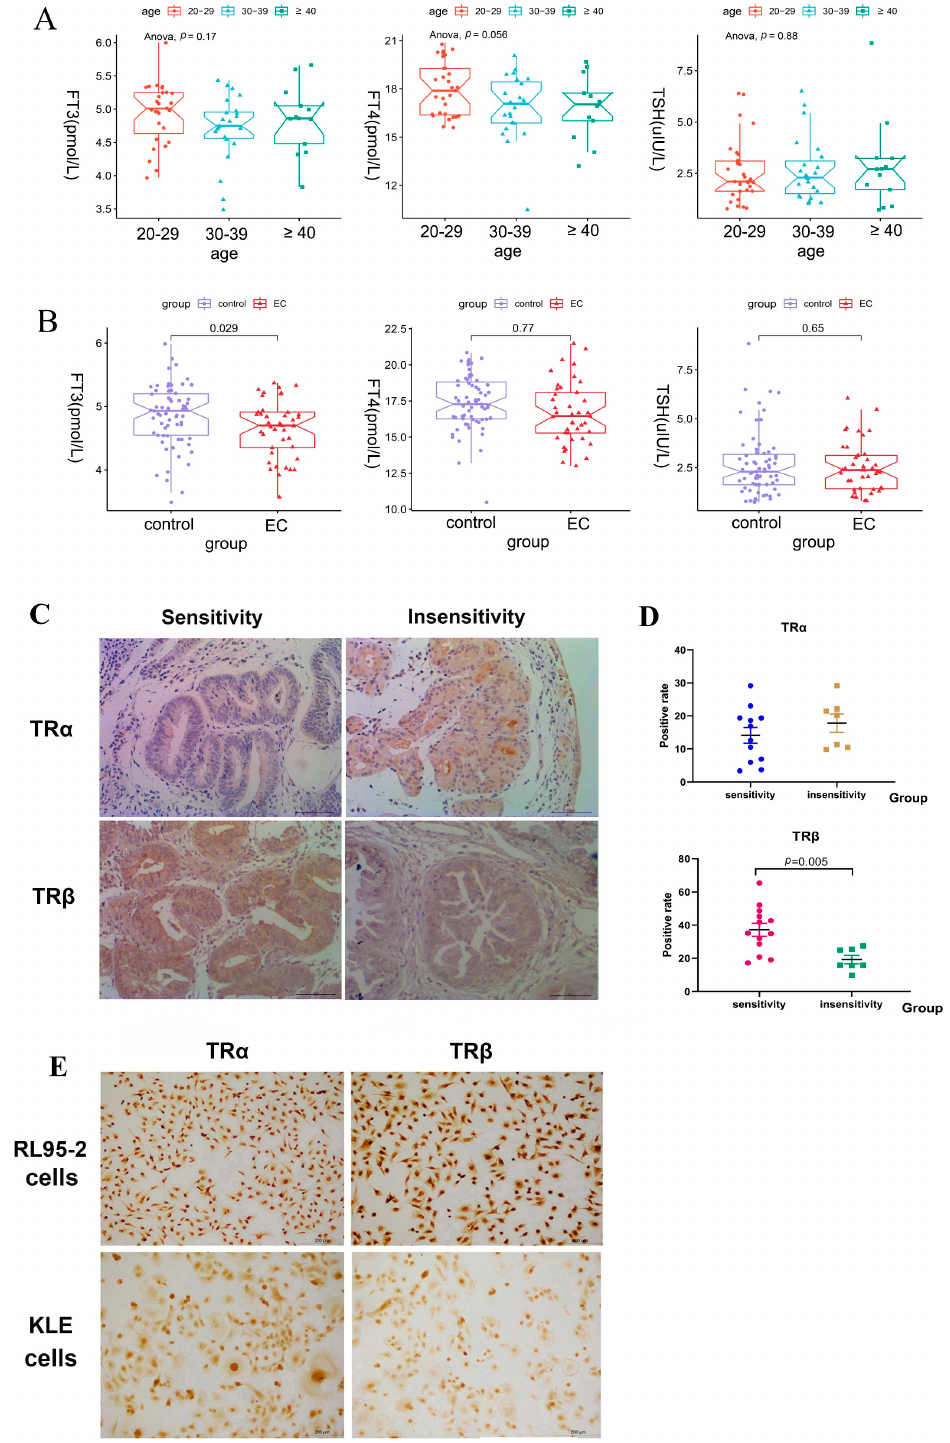
Figure 1. Serum levels of thyroid hormone in healthy women and patients with EC and protein expression of thyroid hormone receptors in the endometrium of patients with EC, endometrial atyp- ical hyperplasia (EAH) and cultured human cells. ( A ) Serum levels of FT3, FT4, and TSH in healthy women of different ages: 20–29 ( n = 31), 30–39 ( n = 23), and more than 40 years of age ( n = 13). ( B ) Serum levels of FT3, FT4, and TSH in the patients with EC ( n = 41) and healthy women group ( n =